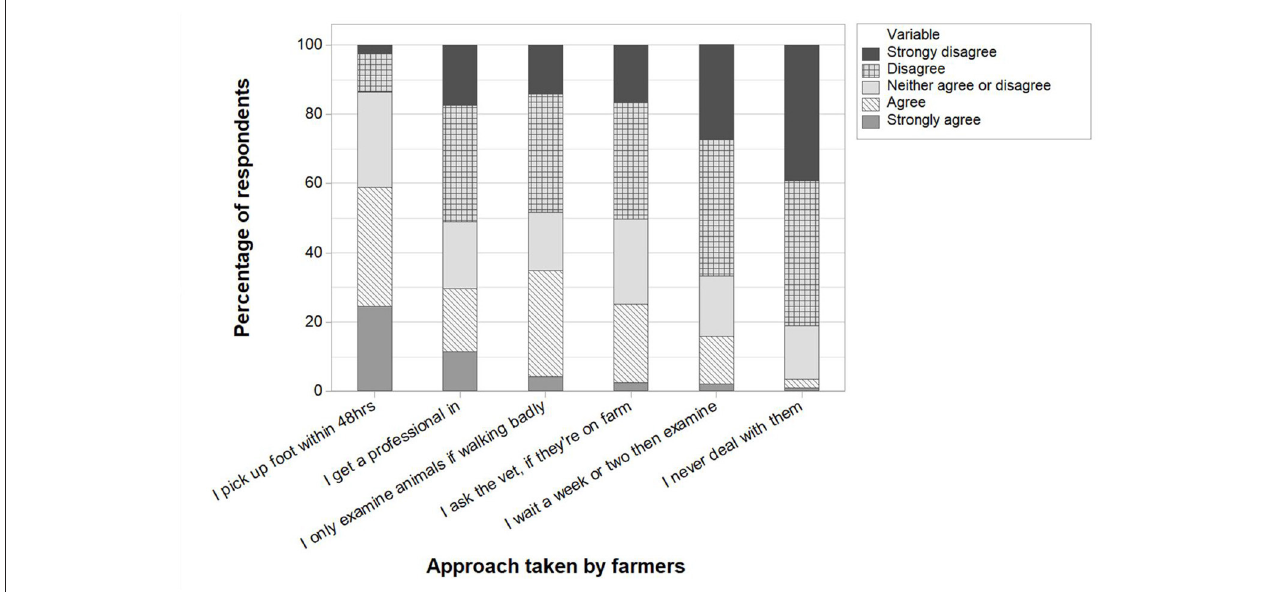
FIGURE 8 | Farmer responses to the level of agreement with approaches that might be taken to deal with lame animals, as a percentage of respondents. Exact wording in the questionnaire was as follows (from left to right on the graph): I pick up the foot of a lame animal within 48h ( n = 483); I personally never pick up feet, but I get my vet or foot trimmer to do it as soon as possible ( n = 478); I only examine animals if they are walking quite badly ( n = 477); I ask the vet to look at a lame animal, but only if the vet happens to be on farm already ( n = 473); I give lame animals a week or two before examining them, to see how they do ( n = 476); I never deal with lame animals, as they get better by themselves ( n = 473). (Q18).